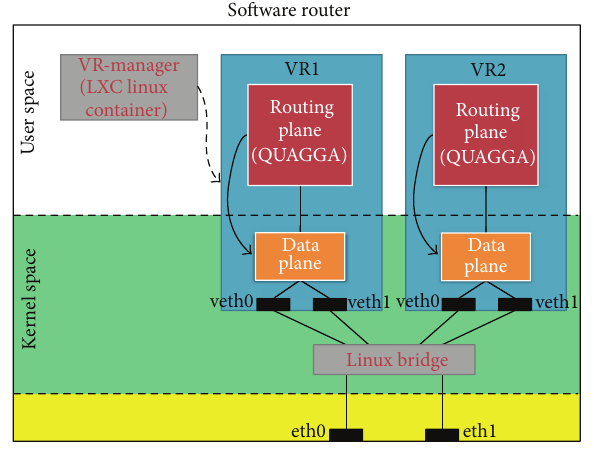
Figure 10: Software Router Architecture supporting virtualization.